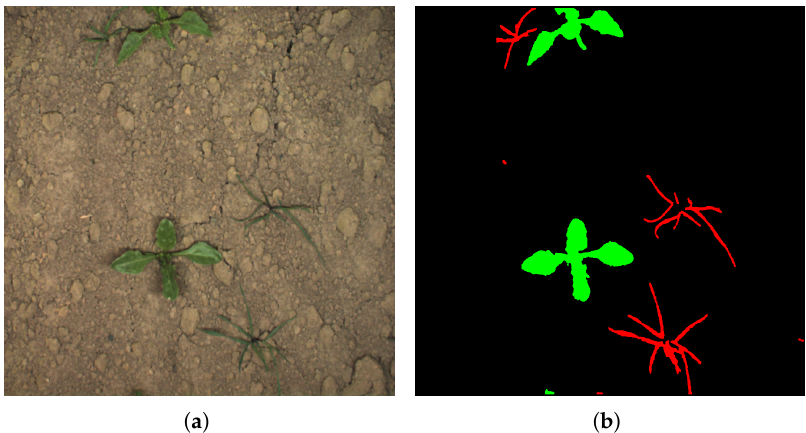
Figure 3. Example of an image found in the Sugar Beets dataset and its respective segmentation mask. ( a ) Image. ( b ) Segmentation mask.